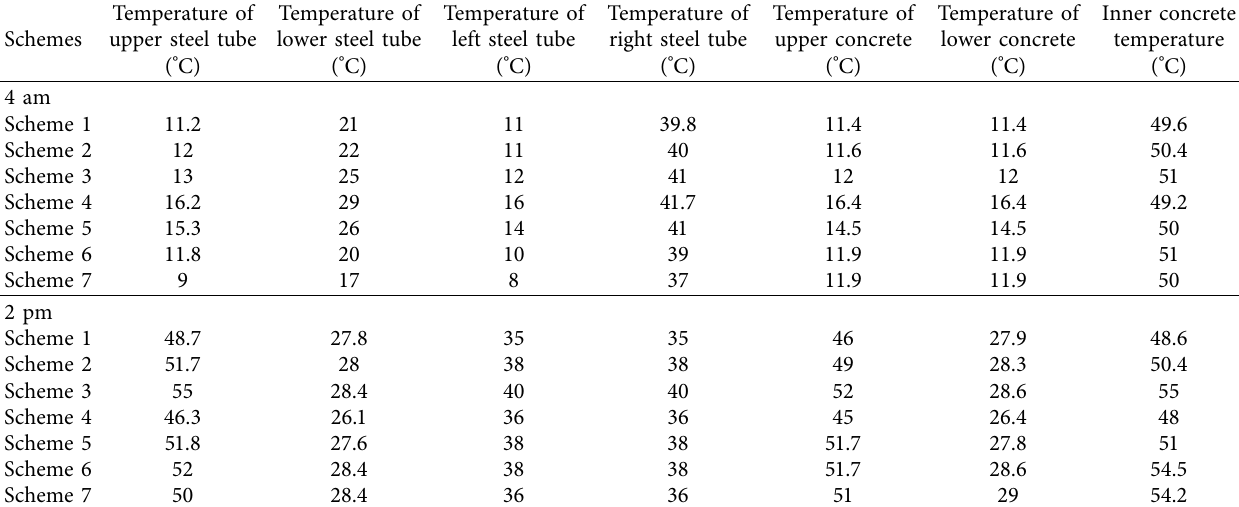
Table 3: The calculation results of the nonuniform